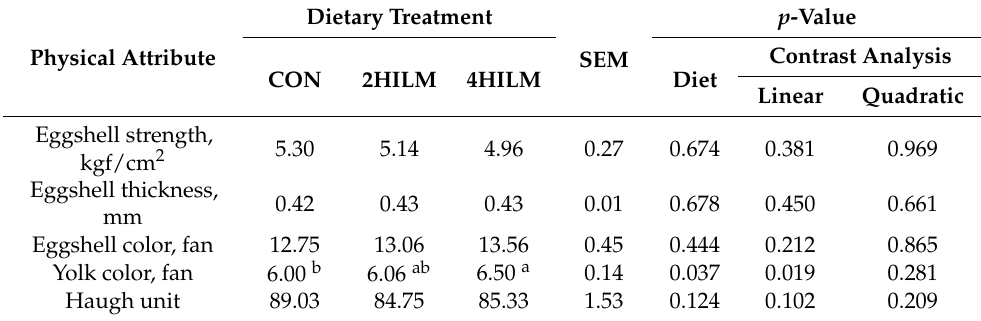
Table 5. Effect of the dietary Hermetia illucens larvae meal (HILM) inclusion level on the quality of the